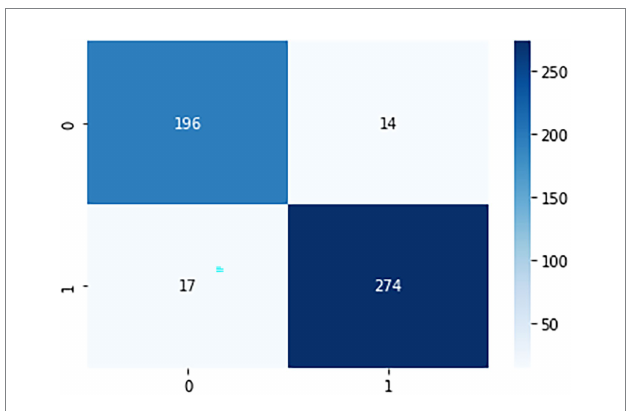
FIGURE 7 Confusion